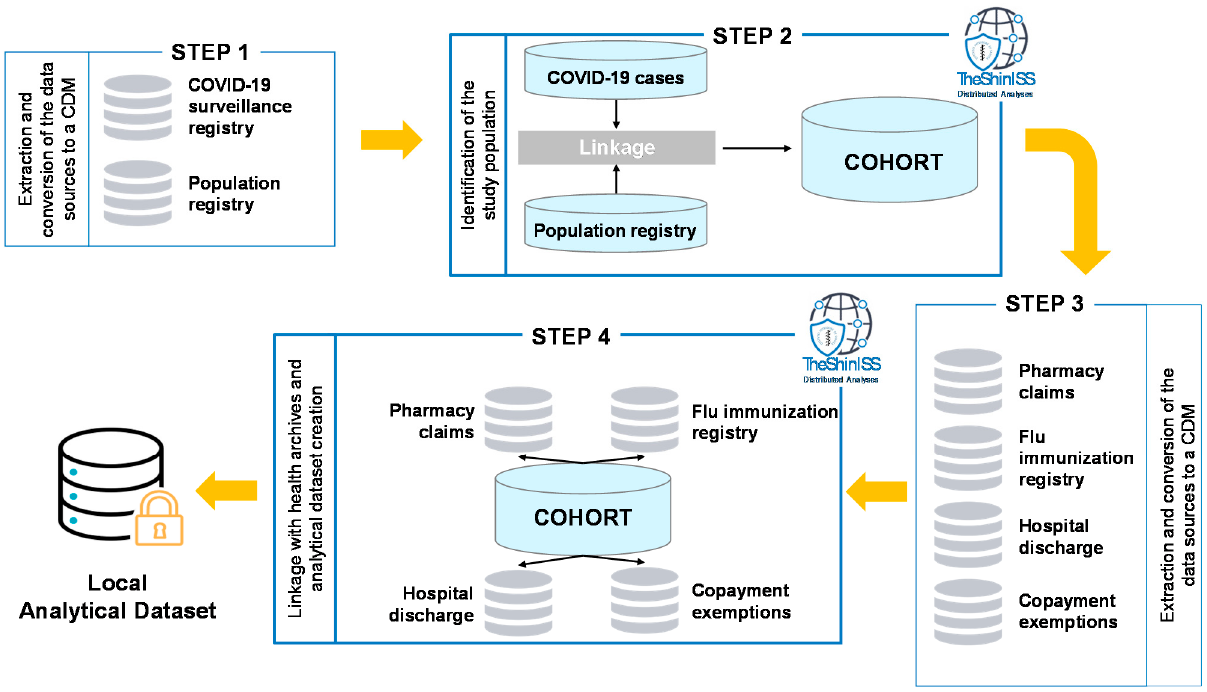
Figure 1. TheShinISS: an open-source tool for conducting distributed analyses within pharmacoepidemiological multi- database studies. Diagram of sequential steps applied to the cohort study design.